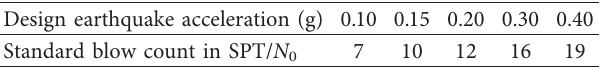
Table 6: Standard blow count N uefaction potential [22].